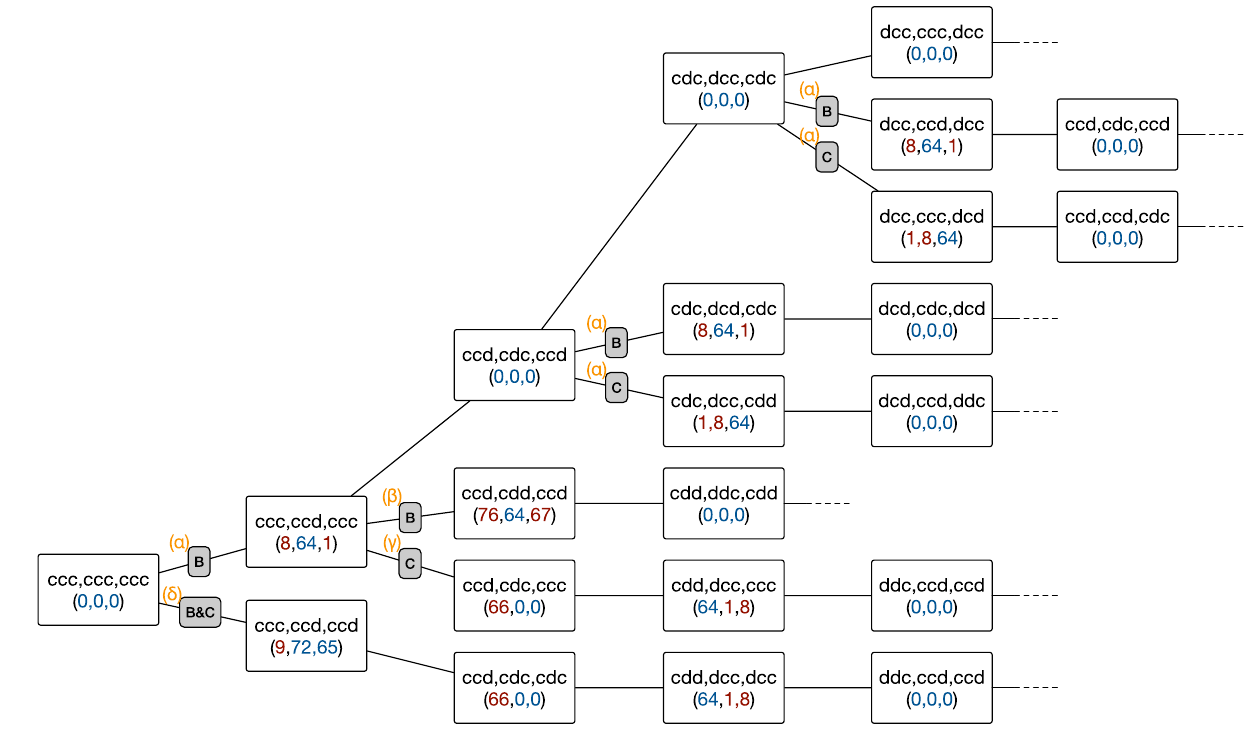
Figure 7. Paths for recovering mutual cooperation from one- and two-bit errors. At each node, we have specified which history profile it represents, together with the corresponding internal state in the state-based representation (see the node labels in Fig. 6). The label of an internal state is written in blue (red) if c ( d ) is prescribed at the state. This figure contains all the possibilities up to permutation of the players. The symbols ‘B’ and ‘C’ in the shaded rectangles indicate who committed implementation error. The orange Greek letters correspond to those in Fig.